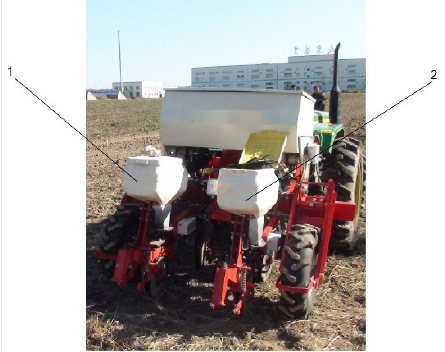
Figure 9. Field experiment. 1. GCSS, 2. EDS.